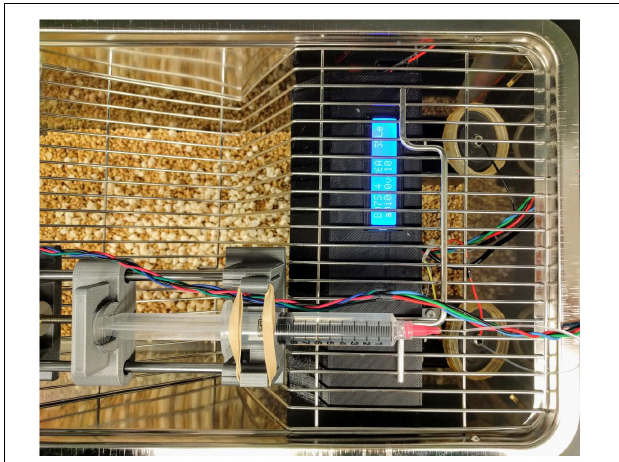
FIGURE 1 | Operant licking device for oral alcohol self-administration. The device has a lick sensor that records licking events from both the active and inactive spouts. Licking on the active spout meeting a variable ratio schedule triggers the syringe pump to push one drop (60 µ l) of alcohol to the tip of